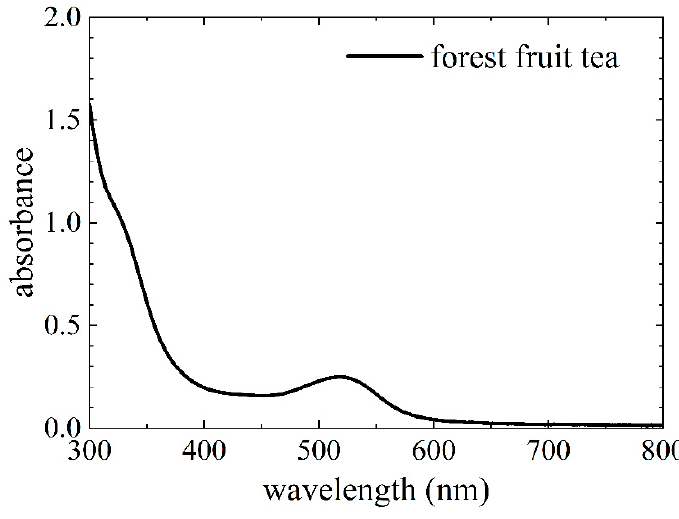
Figure 1. Absorption spectrum of the forest fruit tea dye.